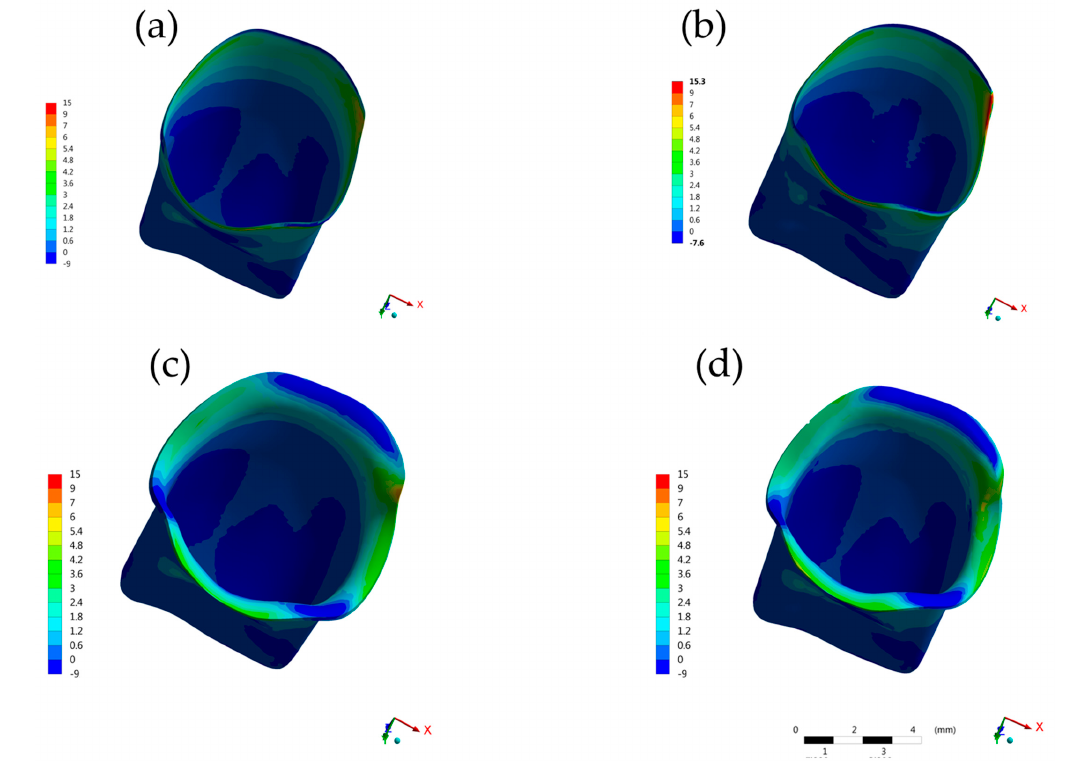
Figure 5. Bottom view of contour plots of each restorative procedure First principal stress (MPa) in the crown cement layer. ( a ) BOPTB, ( b ) BOPT, ( c ) CM and ( d ) SM.